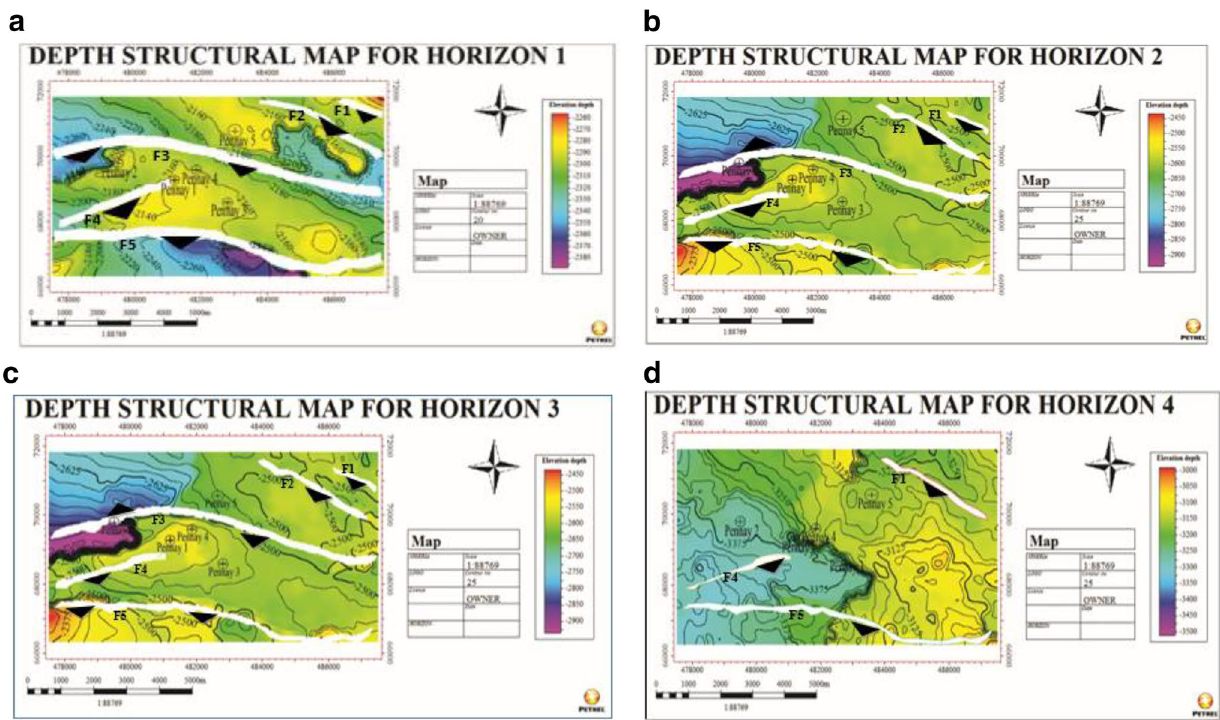
Fig. 12 a Depth structure map of horizon sand A. b Depth structure map of horizon sand B. c Depth structure map of horizon sand C. d Depth structure map of horizon sand